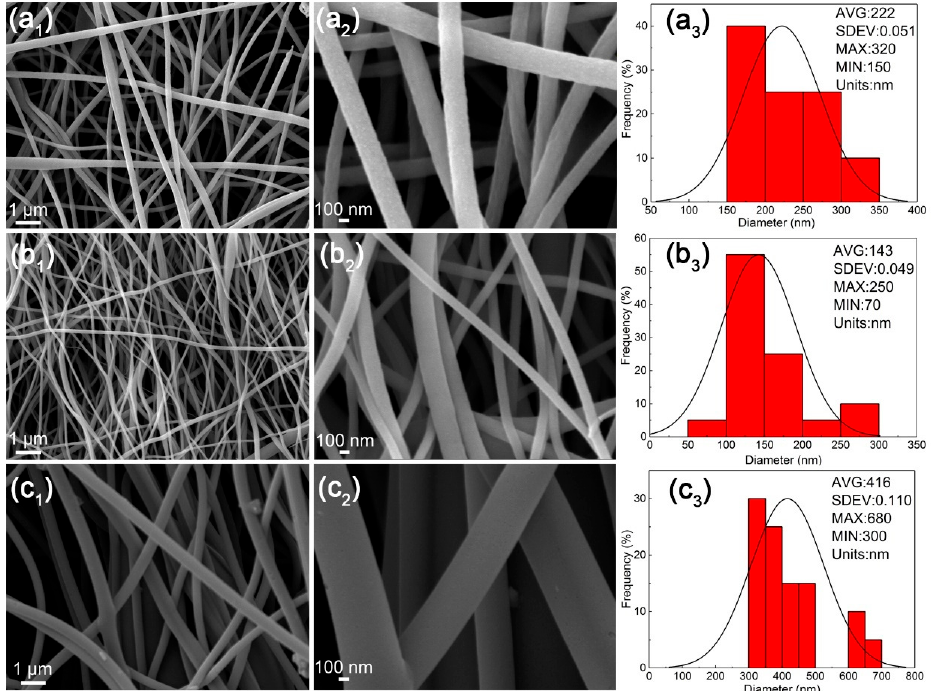
Figure 10. Representative SEM images of ( a 1 – a 2 ) cPAN, ( b 1 – b 2 ) cP(AN-co-IA), and ( c 1 – c 2 ) cP(AN-co- AMPS) nanofibers with different scales. ( a 3 ), ( b 3 ), and ( c 3 ) are diameter distribution histograms corresponding to cPAN, cP(AN-co-IA), and cP(AN-co-AMPS) nanofibers, respectively.